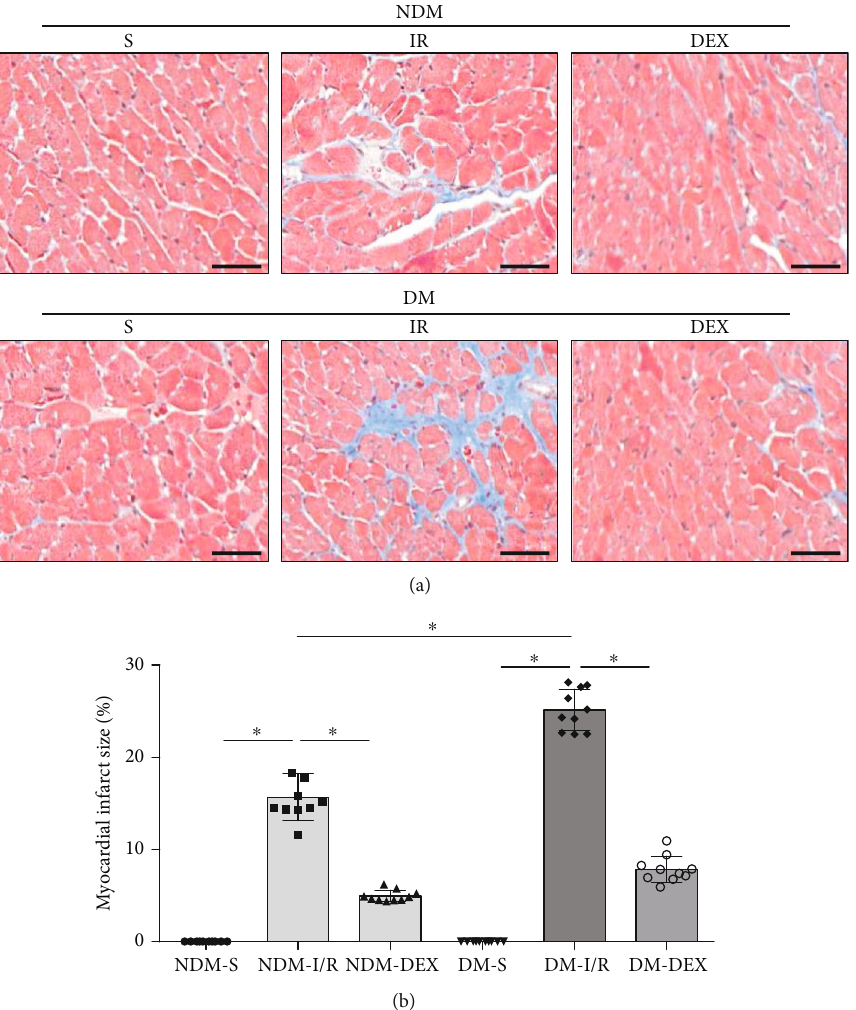
Figure 3: DEX reduces myocardial infarct size in rats. Myocardial infarct size was detected by Masson trichrome staining. (a) Masson staining and myocardial infarction area of rats in each group; the red area represented normal myocardial tissues, while the blue area represented an infarcted myocardium ( scalebar = 50 μ m). (b) The bar graph of myocardial infarct size: infarct size ð % Þ = ð myocardial infarct size/totalleft ventricular area Þ × 100 % . All results are expressed as the mean ± SD . ∗ P < 0 : 05 between each